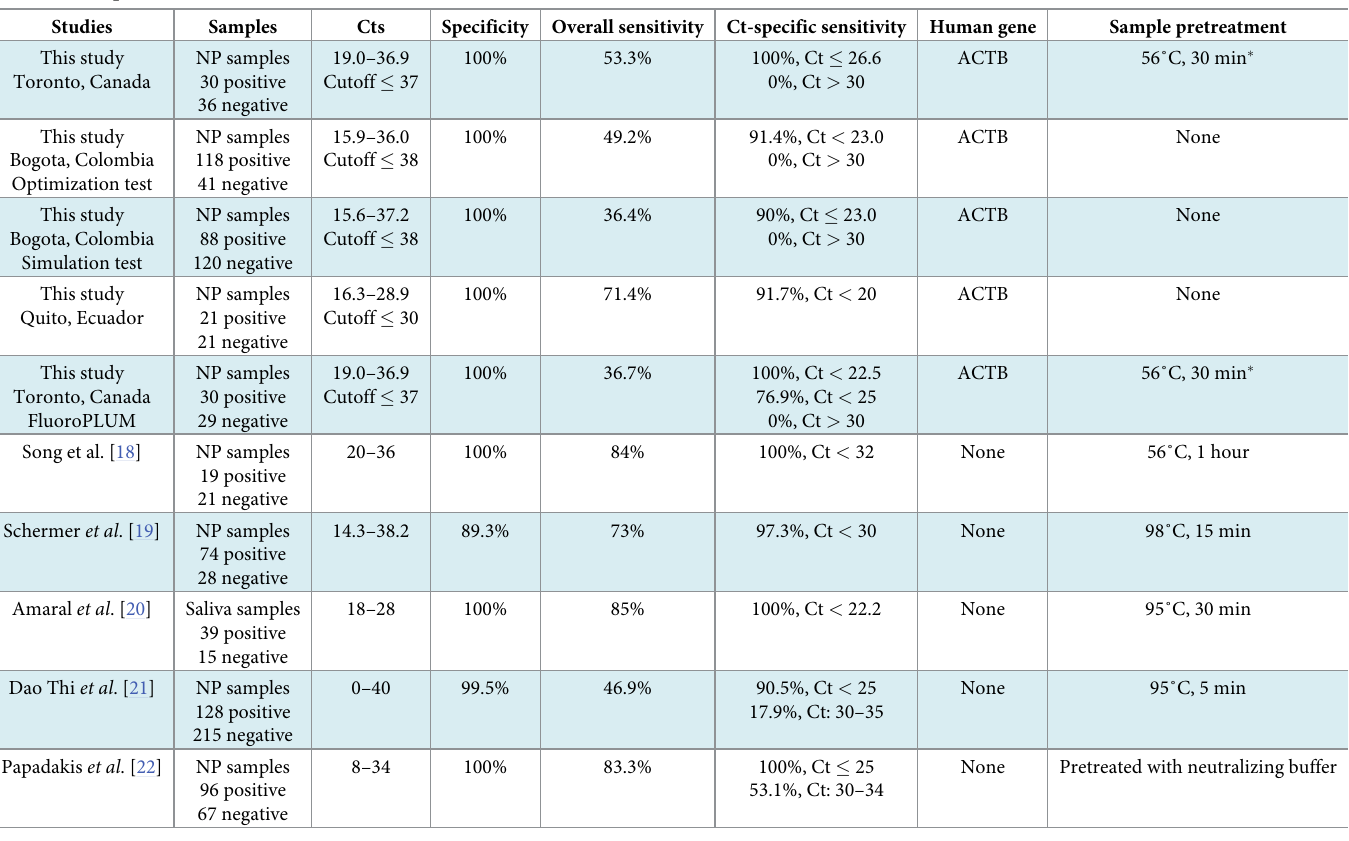
Table 3. Comparisions with other RT-LAMP PoC SARS-CoV-2